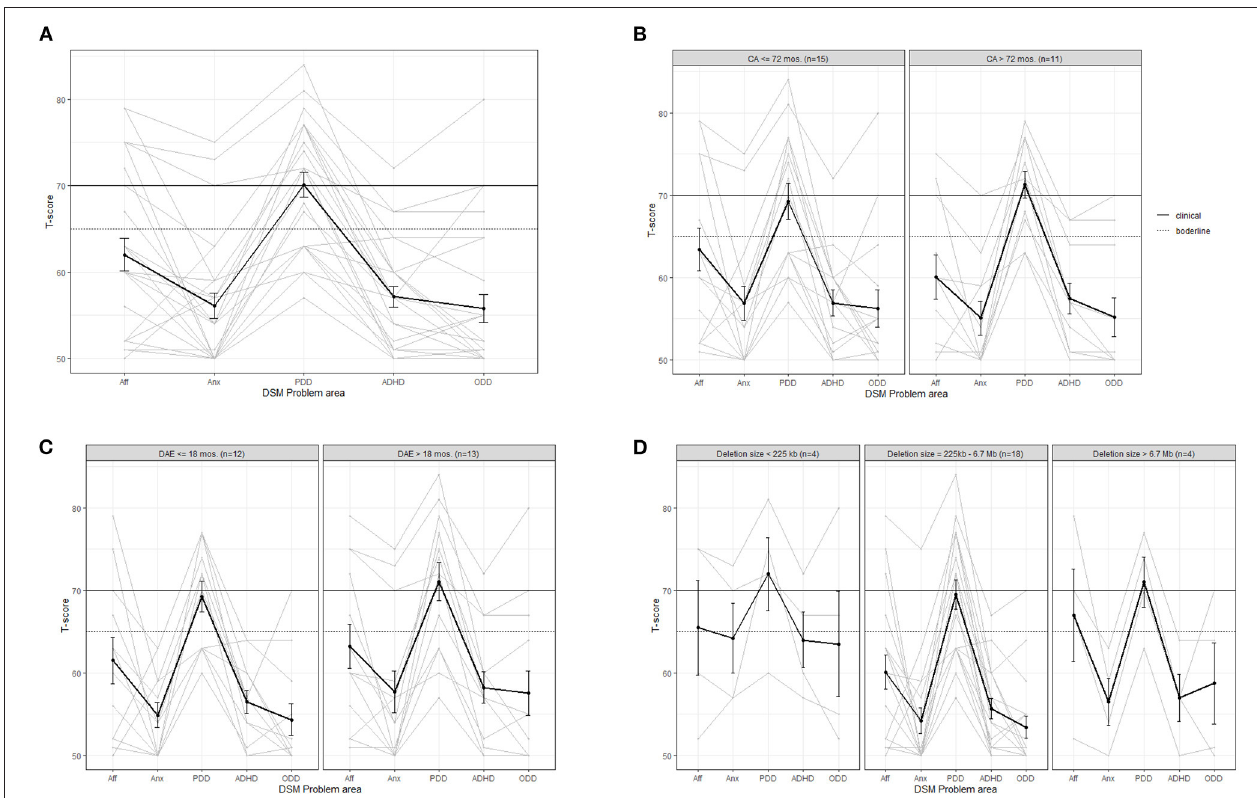
FIGURE 3 | Average (bold line) and individual behavior profiles on the CBCL DSM problem areas for (A) the whole sample and for subgroups based on (B) calendar age (CA), (C) developmental age equivalent (DAE) in months based on cognition scale Bayley-III and (D) deletion size. Aff, affective problems; Anx, Anxiety; PDD, pervasive developmental disorder; ADHD, attention deficit hyperactivity disorder; ODD, oppositional deviant